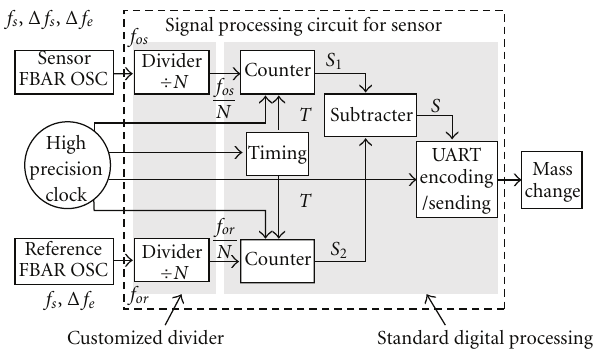
Figure 2: Scheme of FBAR tiny sensor.